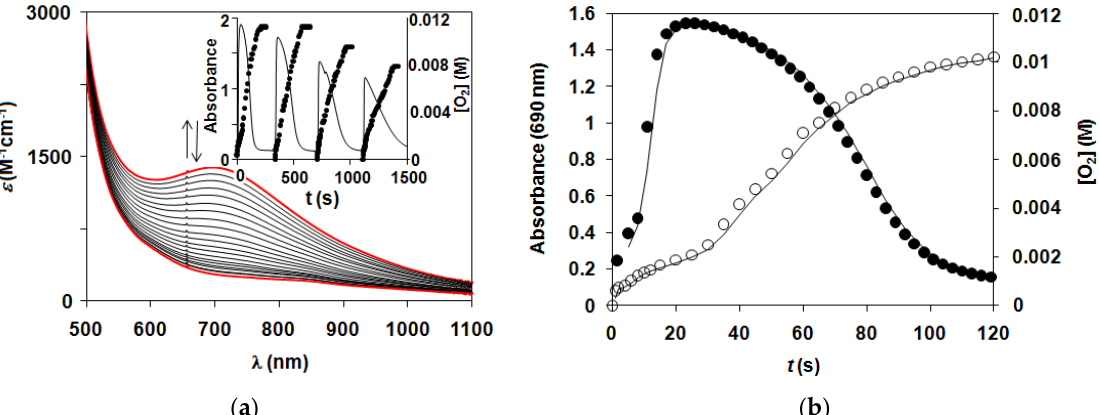
Figure 2. ( a ) UV-Vis spectral changes of 5 during the 1 -catalyzed disproportionation of H 2 O 2 . The inset shows the the time course of the formation and decay of 5 and the parallel formation of dioxygen for 5 cycles. [ 5 ] 0 = 2 mM, [H 2 O 2 ] 0 = 24 mM (4×) in CH 3 CN at 20 ℃ ( b ) Time course for the H 2 O 2 (24 mM) oxidation by 5 (2 mM), monitored at 690 nm in CH 3 CN at 20 ° C and by volumetrically determined amounts of evolved dioxygen. Table 2. Kinetic data for the formation of intermediates 5 , 6 , 7 and 8 in CH 3 CN.